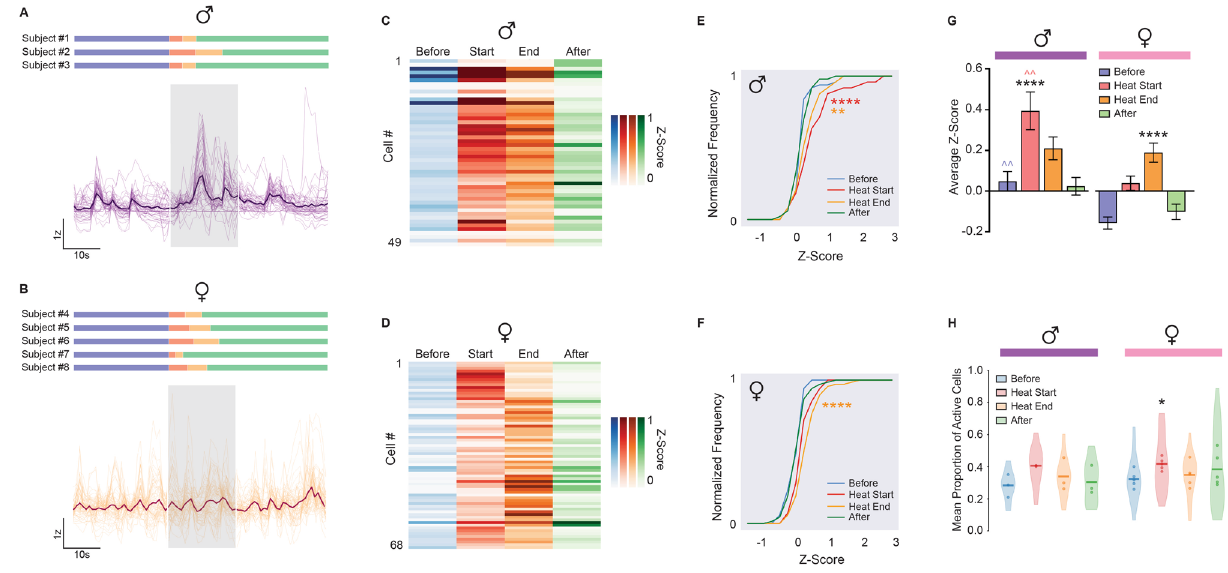
Figure 2. Sex-Dependent BNST CRF Responses to Noxious Heat Exposure by Epoch. ( A–B ) Relative fluorescence change (ΔF/F) of BNST CRF activity during noxious heat exposure. Z-scores of ( A ) male (n = 49 cells / 7–30 cells per mouse) and ( B ) female (n = 68 cells / 8–19 cells per mouse) subjects are represented over time by aligning traces that were averaged across trials to the onset of the heat stimulus. Individual cell activity is indicated in lighter colors, with total average cell activity in darker colors, and maximum heat duration (20 s) in the transparent blue block. Scale bars, x = time (10 s), y = z-score based on relative ΔF/F (1 z-score). Imaging timelines for individual subjects are located above to represent epochs via the color-coding system described in Fig. 1A: Before (blue), Heat Start (red), Heat End (orange), and After (green). Similar color designations apply for all panels of Fig. 2. ( C–D ) Heatmap exhibiting the average z-score of individual BNST CRF neurons by epoch for ( C ) male and ( D ) female subjects. Darker shades of color correspond to greater changes in Ca 2+ activity relative to baseline. ( E–F ) Cumulative distribution function plotting the z-score frequency by epoch in ( E ) male and ( F ) female subjects (KS test: By Sex-Before [D(117) = 0.3466, P value = 0.0014], Heat Start [D(117) = 0.3850, P value = 0.0002], Heat End [D(117) = 0.1815, P value = 0.2759], After [D(117) = 0.2611, P value = 0.0334]; Comparing each epoch within males results in significance with Heat Start and Heat End over Before and After [Before vs. Heat Start, D(98) = 0.4694, P value = 2.183e−05; Before vs. Heat End, D(98) = 0.4286, P value = 0.0001; Heat Start vs. After, D(98) = 0.4082, P value = 0.0003; Heat End vs. After, D(98) = 0.3265, P value = 0.0079], whereas comparing each epoch within females results in significance with Heat End over Before, Heat Start, and After [Before vs. Heat Start, D(136) = 0.2647, P value = 0.0135; Before vs. Heat End, D(136) = 0.4558, P value = 7.372e−07; Heat Start vs. Heat End, D(136) = 0.2352, P value = 0.0386; Heat Start vs. After, D(136) = 0.2941, P value = 0.0041; Heat End vs. After, D(136) = 0.3970, P value = 2.634e−05]). ( G ) Comparing average z-scores of BNST CRF neurons by epoch for male and female subjects (Two-way mixed- model ANOVA with Tukey’s post hoc: Sex × Epoch interaction [F(3, 345) = 5.996, P = 0.0005], main effect of Sex [F(1, 115) = 13.20, P = 0.0004] and Epoch [F(2.153, 247.7) = 26.31, P < 0.0001]). denotes comparison of epochs for each sex, ^ denotes comparison of the same epoch between sexes. ( H ) Neuronal coactivity as measured by mean proportion of active BNST CRF neurons. At each frame (0.2 s), the fraction of cells exhibiting positive z-scores was calculated and binned by epoch to reveal the proportion of concurrent BNST CRF activity at phases relative to heat exposure (Two-way mixed-model ANOVA with Sidak’s post hoc: no Sex × Epoch interaction [F(3, 18) = 0.5414, P = 0.6601] or main effect of Sex [F(1, 6) = 0.9203, P = 0.3744]; main effect of Epoch [F(1.840, 11.04) = 4.163, P = 0.0475]). Data are shown as mean ± SEM. * P < 0.05; ** P < 0.01; *** P < 0.001, **** P <